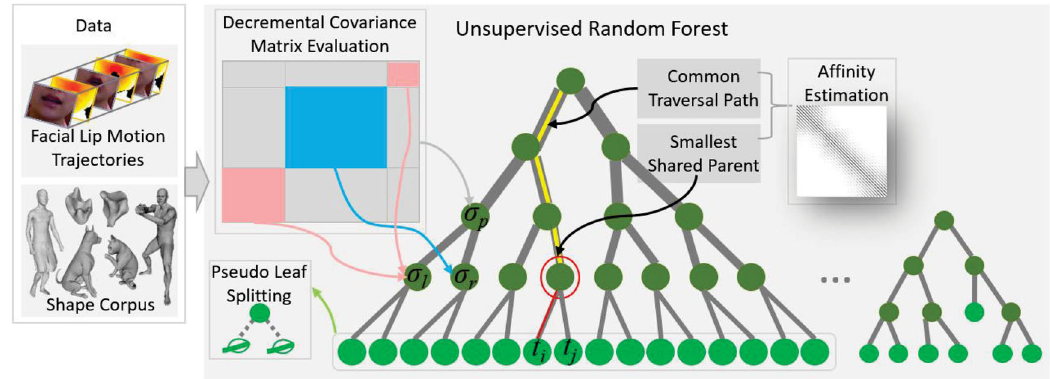
Fig. 1 Our proposed unsupervised random forest-based metric for affinity estimation. The forest-based continuous metric is defined using both the length of the common traversal path and the cardinality of the smallest shared parent node. A pseudo-leaf-splitting algorithm is proposed to account for spatial relationships, regularising affinity measures and inconsistent leaf assignments. Decremental covariance matrix evaluation is used to reduce learning